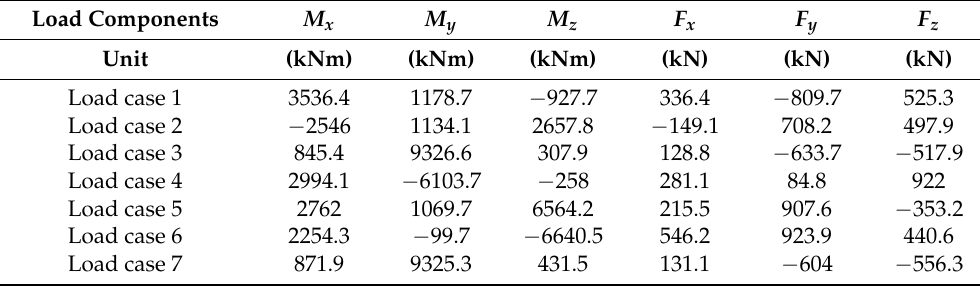
Table 4. Extreme loads at the hub